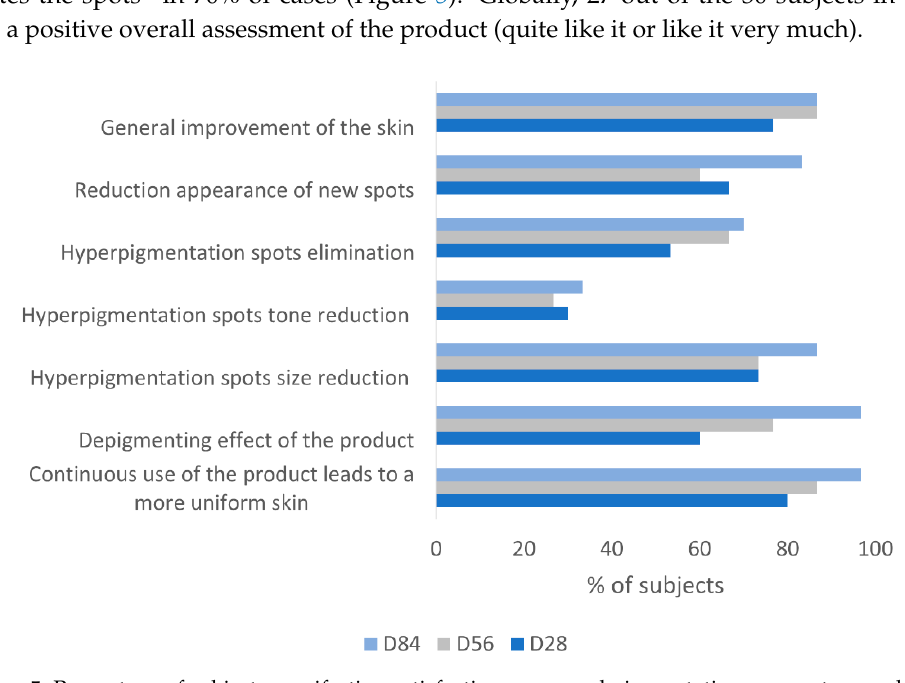
Figure 5. Percentage of subjects manifesting satisfaction on several pigmentation parameters evaluated throughout the study (D28, D56 and D84).